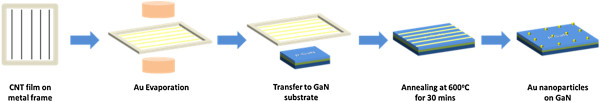
Fabrication process of the Au nanoparticles using an Au-CNT system.